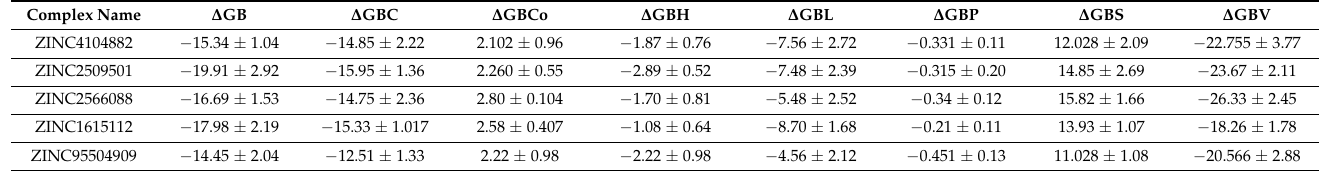
Table 2. A list of different energy components and net MM/GBSA binding free energy (kcal/mol) and standard deviation values generated from the docking poses of the selected four compounds, including the control ligand (ZINC95504909).